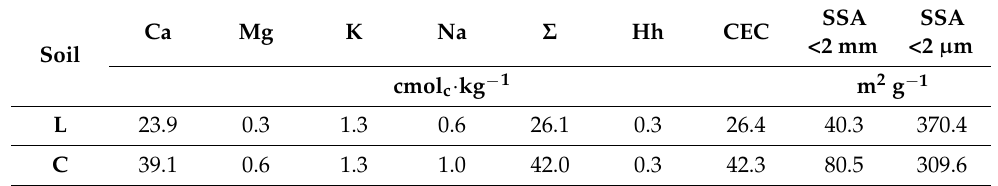
Table 5. The summary of exchangeable cations on studied soils and their specific surface areas.